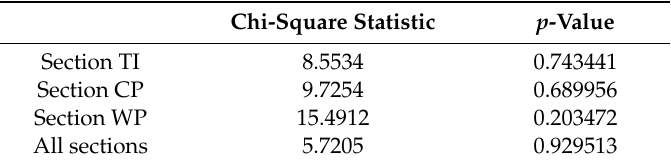
Table 7. Results of the chi-square test by